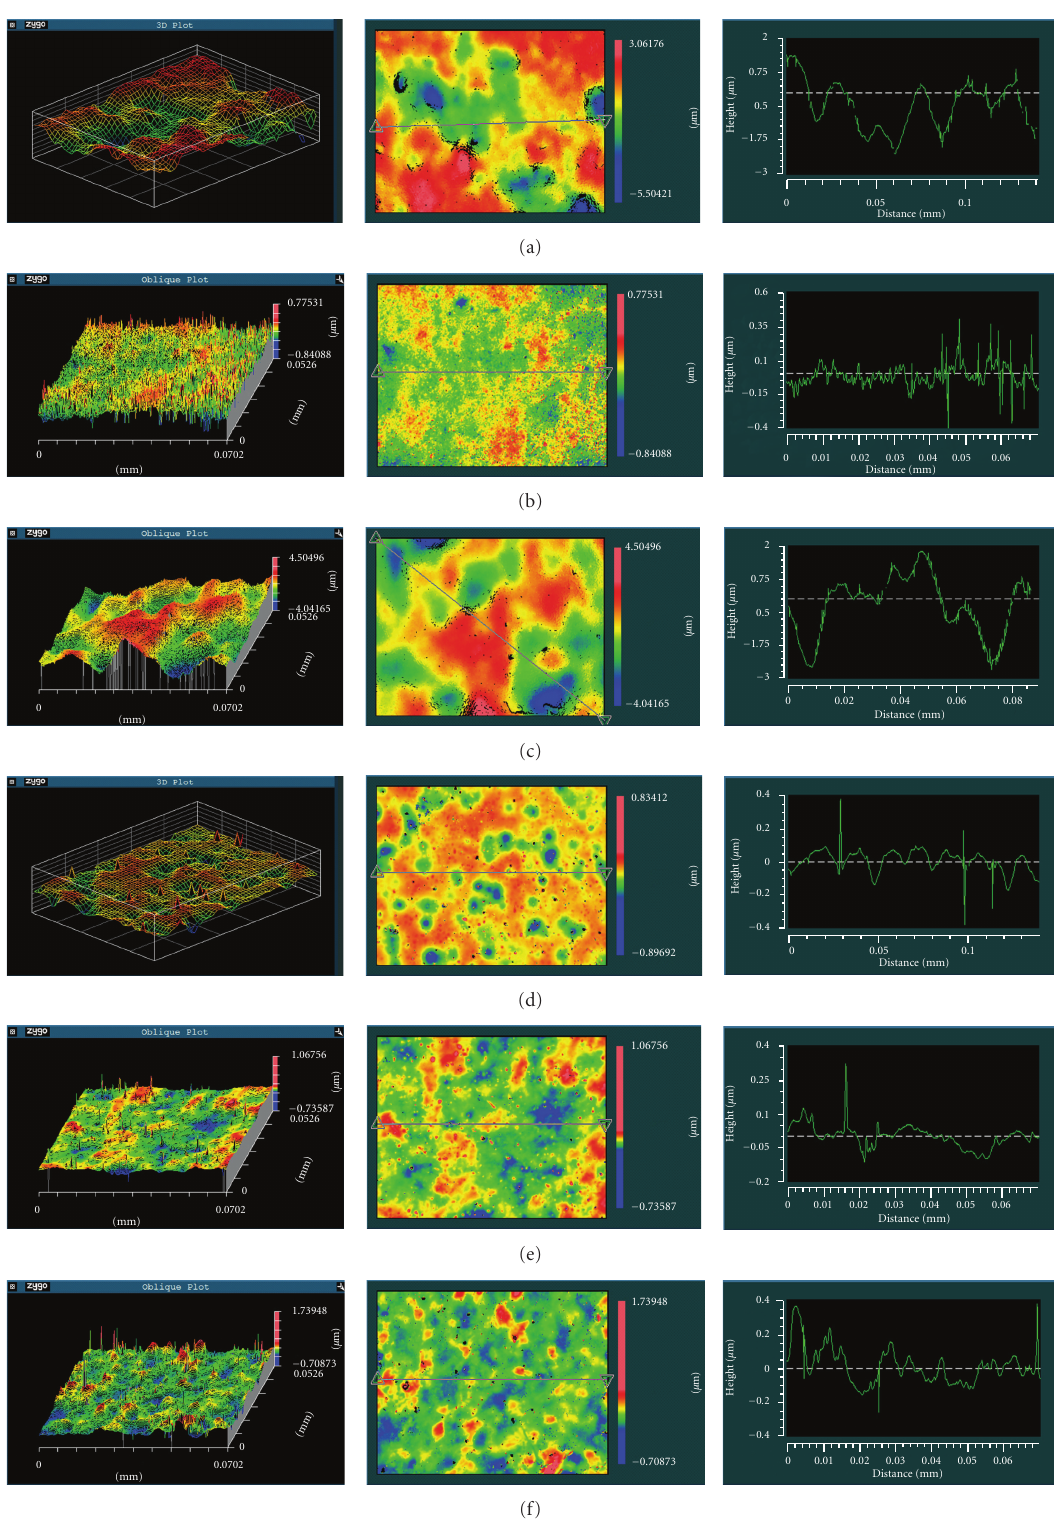
Figure 4: From left to right in each line are a 3D image, 2D image, and profile of the NiTi surface along the direction Δ - ∇ in the 2D image; optical profilometry, final treatment (Table 1): (a) chemical etching (A), (b) modification with Zr ion beams (AG), (c) modification with Ti ion beams (AH), (d) mechanical polishing and electropolishing (B), (e) modification with Ti ion beams (BH), and (f) modification with Si ion beams